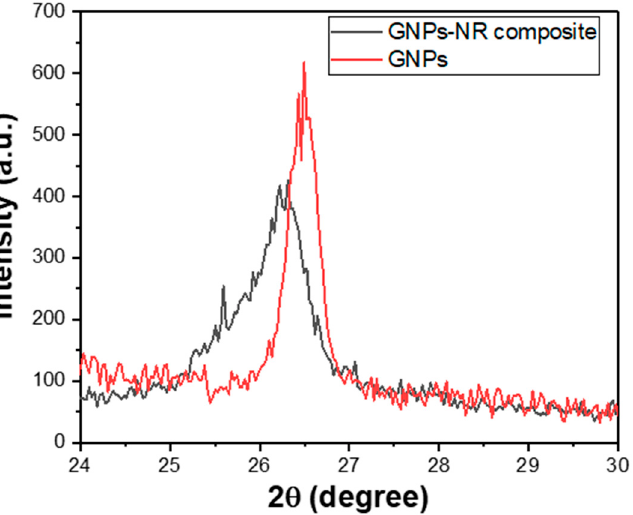
Figure 4. The XRD patterns of the modified GNPs ( red line ) and the modified GNPs/NR composite ( black line ).